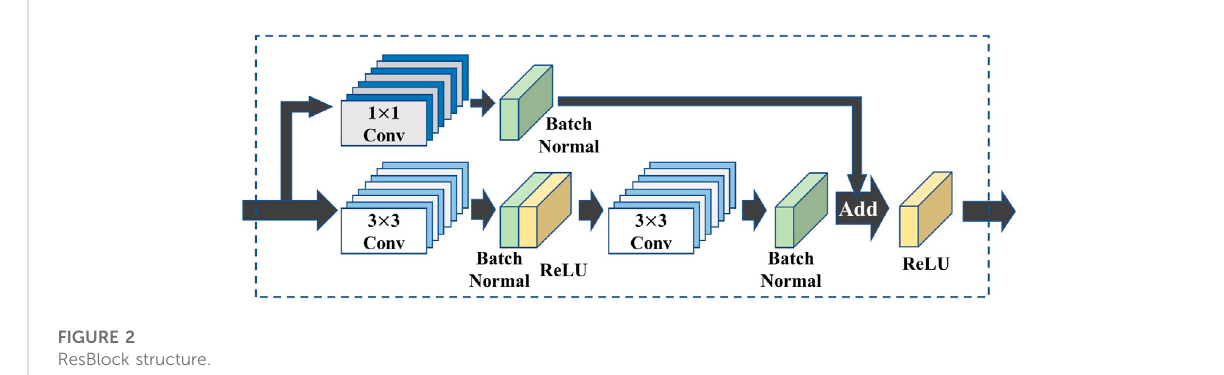
FIGURE 2 ResBlock structure.